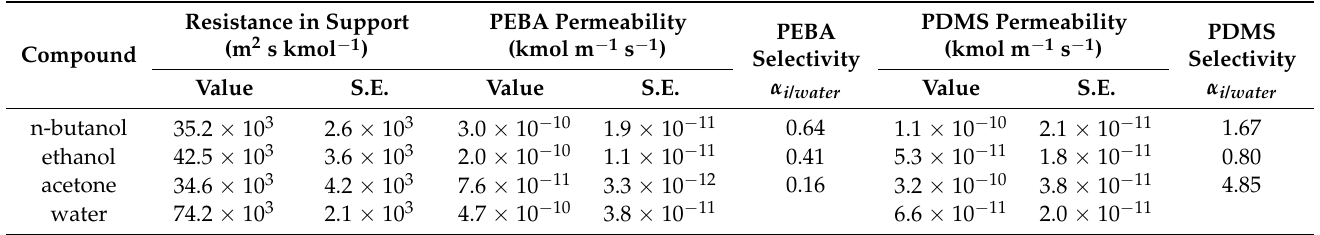
Table 3. Mass transfer resistance of the support and permeability of the membrane selective layers.